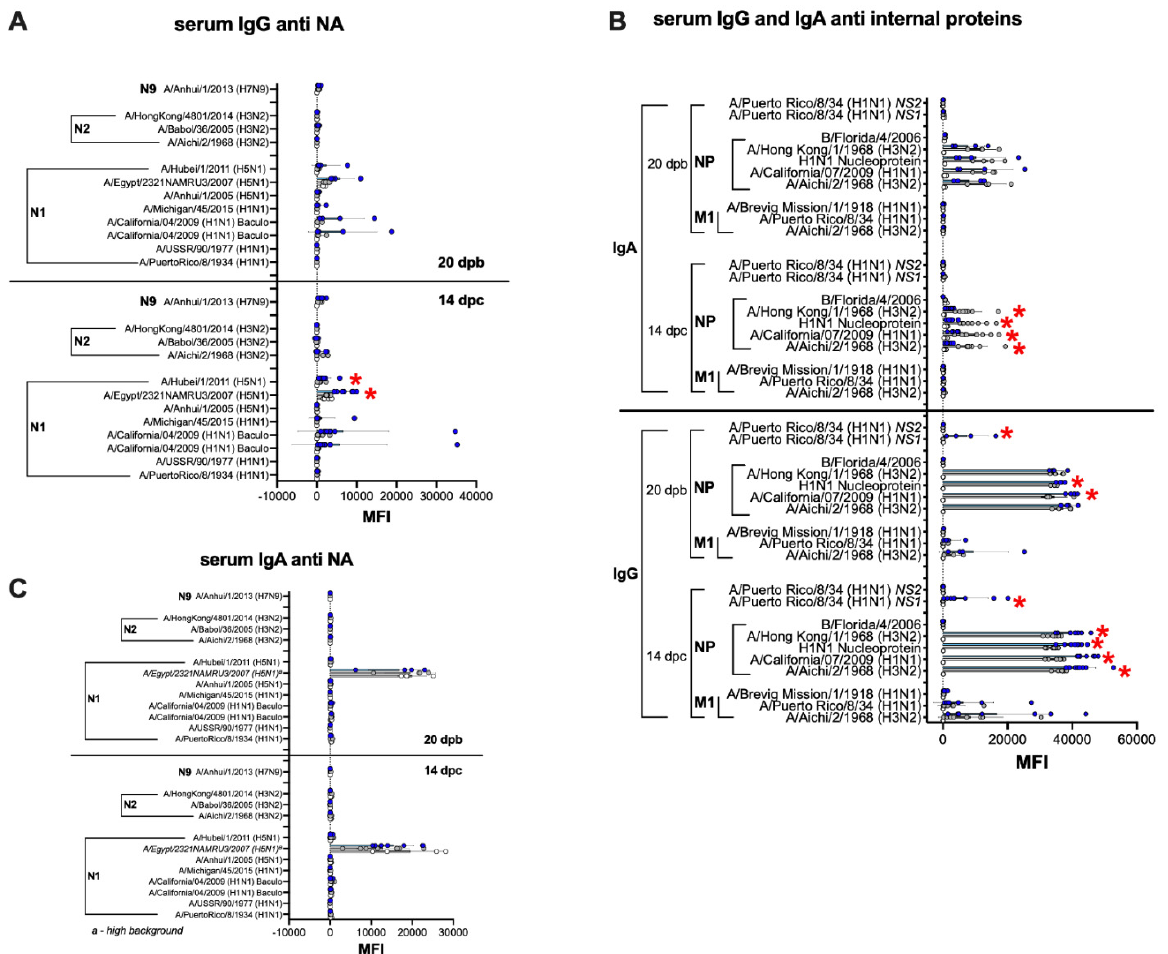
Figure 9. Serum antibody responses against NA and IAV internal proteins. The same set of samples described in Figure 4 (20 dpb) and Figure 6 (14 dpc) were probed for anti-NA ( A , C ) and anti-IAV internal proteins ( B ) antibody responses against antigens on the protein microarrays panel as indicated on the graphs. ( C ) a Data on N1 NA A/Egypt/2321NAMRU3/2007 (H5N1) antigen was not used for analyses due to high background. Statistically significant differences between IGIP-H1att and caLen marked with red asterisks.